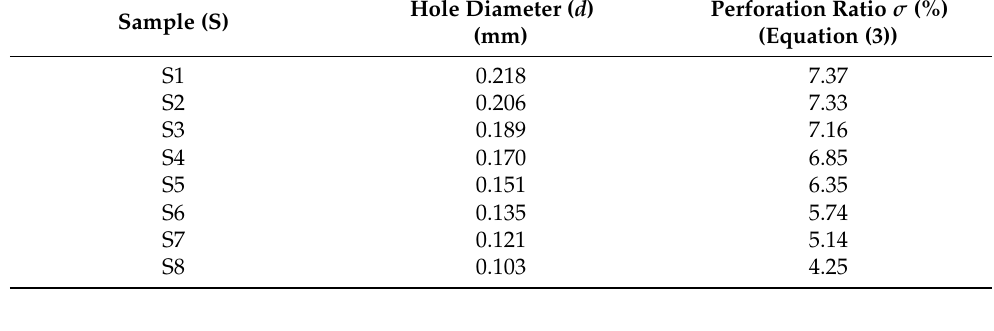
Table 2. Hole diameter and perforation ratio woven fabrics.